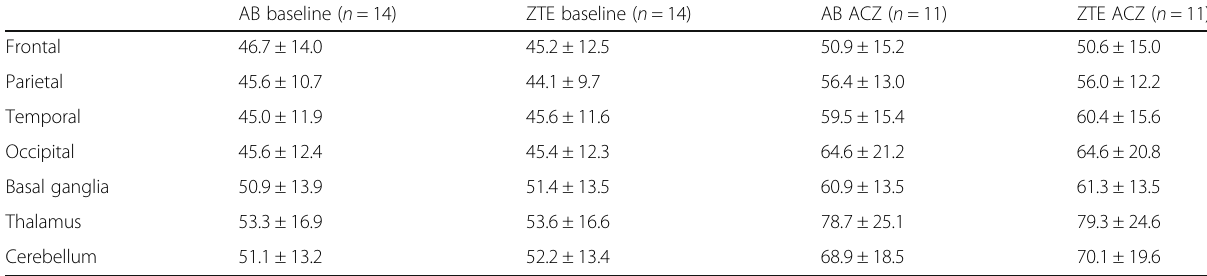
Table 1 Regional CBF values (mL/min/100 g) from two MRAC methods (mean ±